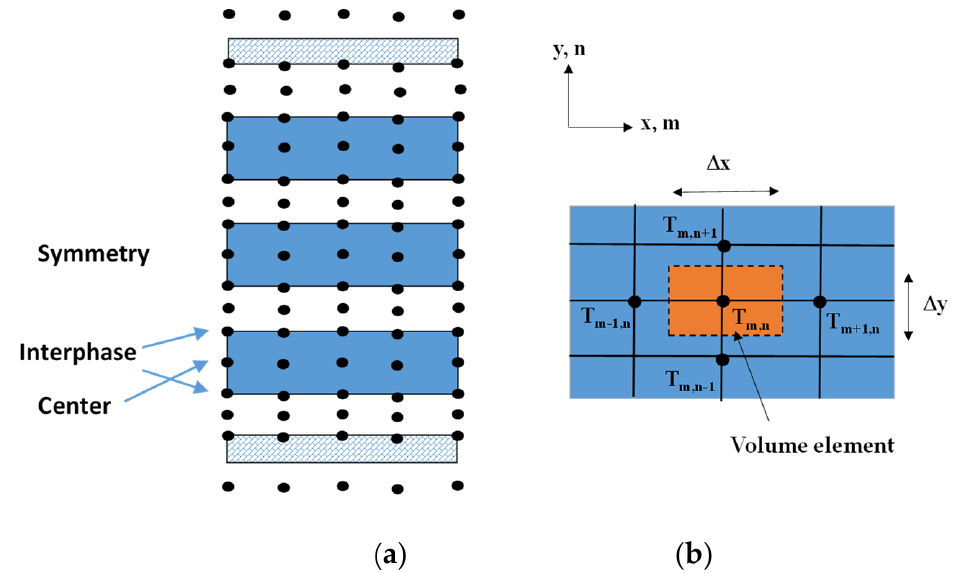
Figure 2. Schematic discretization of ( a ) the rectangular container of the LHST; ( b ) the volume element of a node (m, n).